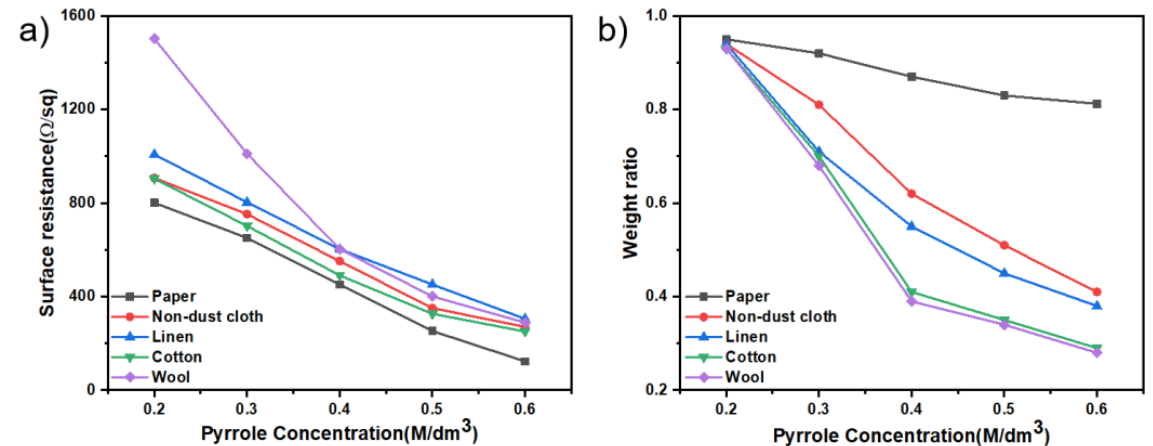
Figure 10. PPy/CNCs deposited different fiber substrates ( a ) Surface resistance on different fiber substrates varies with the concentration of Py. ( b ) Ratio between the weight of the conductive layer after multiple washes and the initial deposited weight, on different fiber substrates and different Py concentrations.